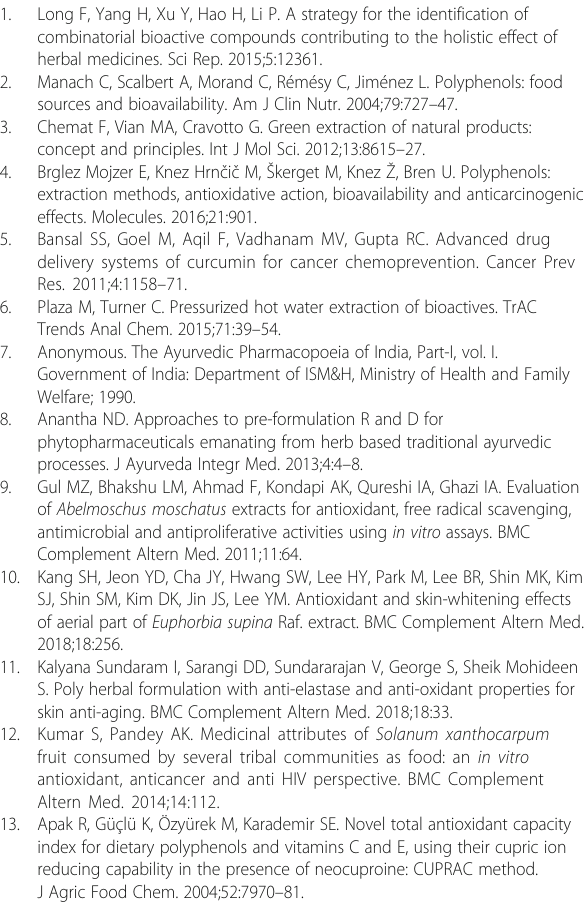
Additional file 2: HPLC-PDA chromatograms of standards and plant extracts and figure for mitochondrial membrane potential. Figure S1. HPLC-PDA chromatogram of polyphenolic standards. Figure S2. HPLC- PDA chromatogram of Punica granatum L. (peel) extract. Figure S3. HPLC-PDA chromatogram of Putranjiva roxburghii Wall. (leaves) extract. Figure S4. HPLC-PDA chromatogram of Swertia chirata Buch.-Ham. (whole herb) extract. Figure S5. HPLC-PDA chromatogram of Tinospora cordifolia (Willd.) Miers (stem) extract. Figure S6. HPLC-PDA chromato- gram of Trigonella corniculata L. (seed) extract. Figure S7. Percent de- crease in Rhodamine intensity in HepG2 cells after treatment with IC 50 value of Herbal combination (DOCX 2931